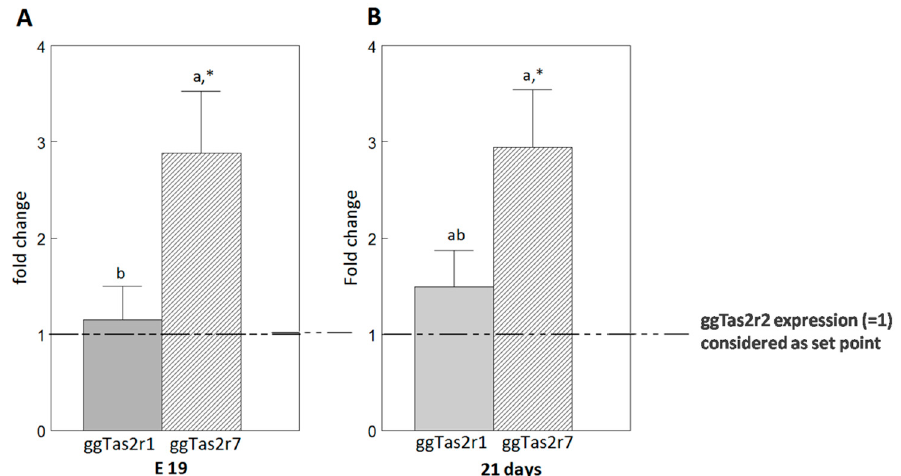
Figure 3. Relative mRNA abundance of ggTas2r-encoding genes ( ggTas2r1 , ggTas2r2 , ggTas2r7 ) on E19 ( A ) and at 21 days ( B ) with the ggTas2r2 serving as the set-point gene (relative expression set to 1, n = 6), obtained from data published in Cheled-Shoval et al. [18]. Values are presented as mean fold change ±SEM. Differences among the ggTas2r1 and ggTas2r7 genes within the palate: means without a common letter differ significantly ( p < 0.05); differences between the tested genes ( ggTas2r1 and ggTas2r7 ) and the control gene ( ggTas2r2 ) within the palate: means with an asterisk (*) differ significantly from ggTas2r2 .